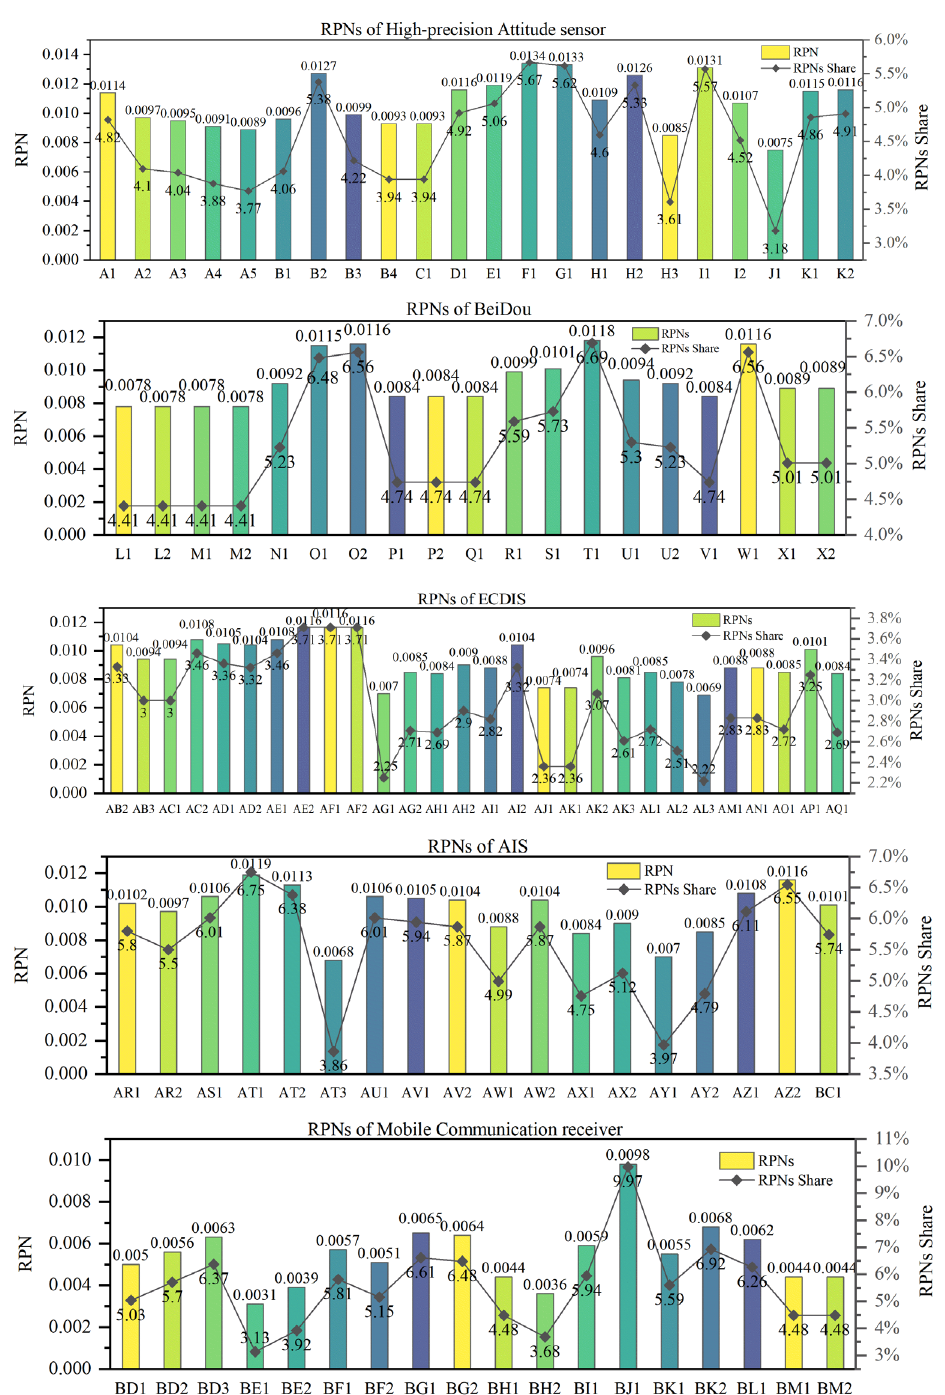
Figure 3. RPNs value and percentage of each cause of failure in the positioning system.